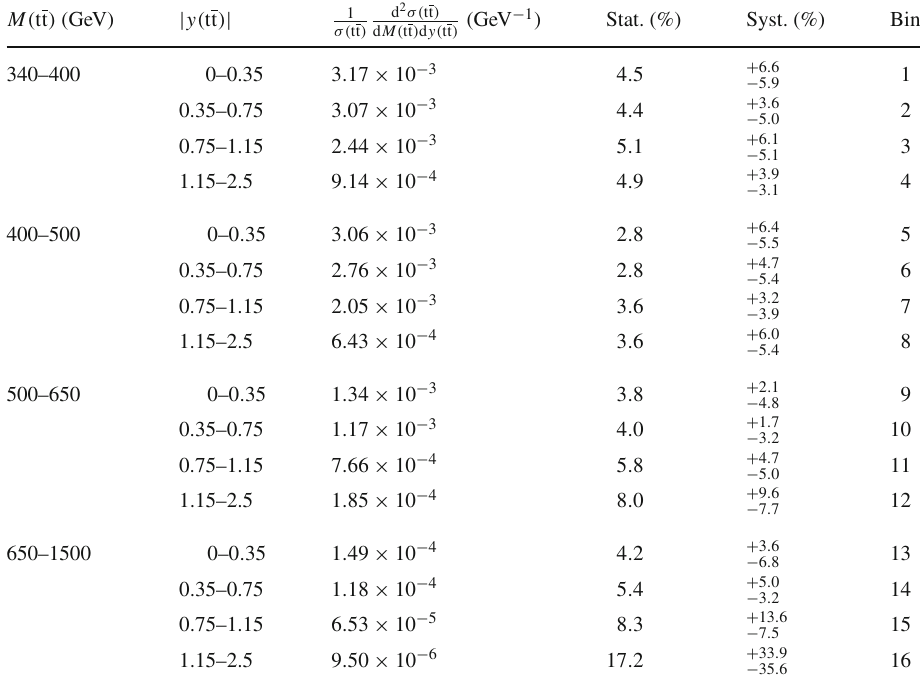
normalized tt double-differential cross sections in different bins of M ( tt ) and y ( tt ) , along with their relative statistical and systematic uncertainties